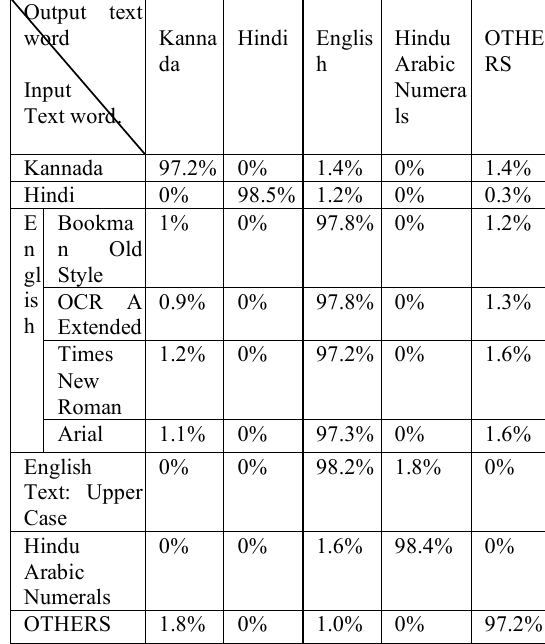
Table 4. Percentage of experimental results of word-wise language identification.